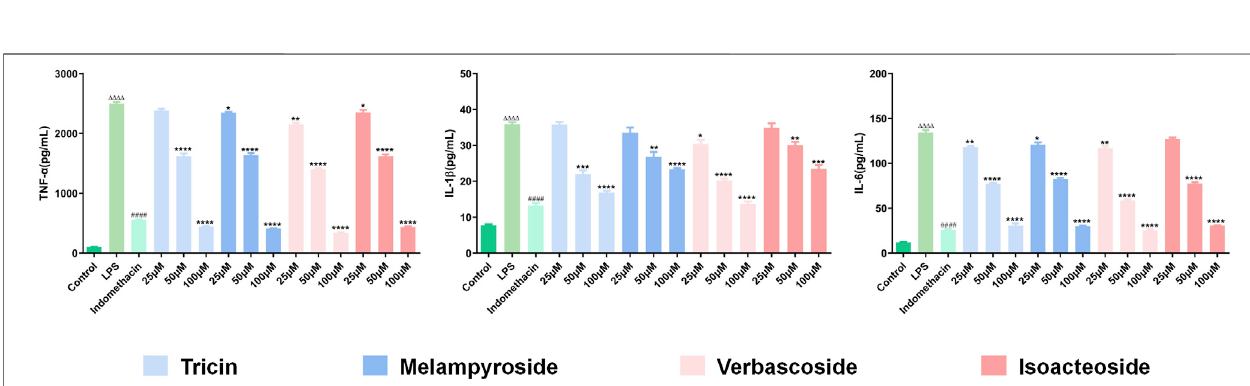
FIGURE 10 | (A) Effect of target compounds of O. vulgaris extracts on viability of RAW 264.7 cell. (Af) melampyroside. (Ag) verbascoside. (Ah) isoacteoside. (Ai) tricin. Data are presented as means ± SD, n (cid:2) 5. **** means p < 0.0001 compared with control group; (B) Effects of different target compounds of O. vulgaris on NO secretion in RAW 264.7 cells induced by LPS. (Bf) melampyroside. (Bg) verbascoside. (Bh) isoacteoside. (Bi) tricin. Data are presented as means ± SD, n (cid:2) 5. * means p < 0.05, ** means p < 0.01, *** means p < 0.001, **** means p < 0.0001 compared with LPS group. #### means p < 0.0001 compared with LPS group. △△△△ means p < 0.0001 compared with control group.